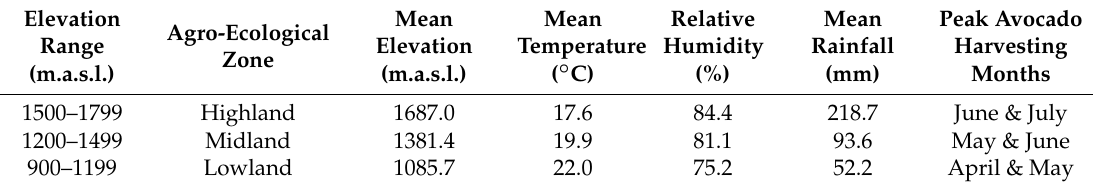
Table 1. Annual weather (Mean) of agro-ecological zones along the study region. The data were averaged from information that was collected at the Taita Hills and Mount Kilimanjaro transects between August 2012 and July 2014.